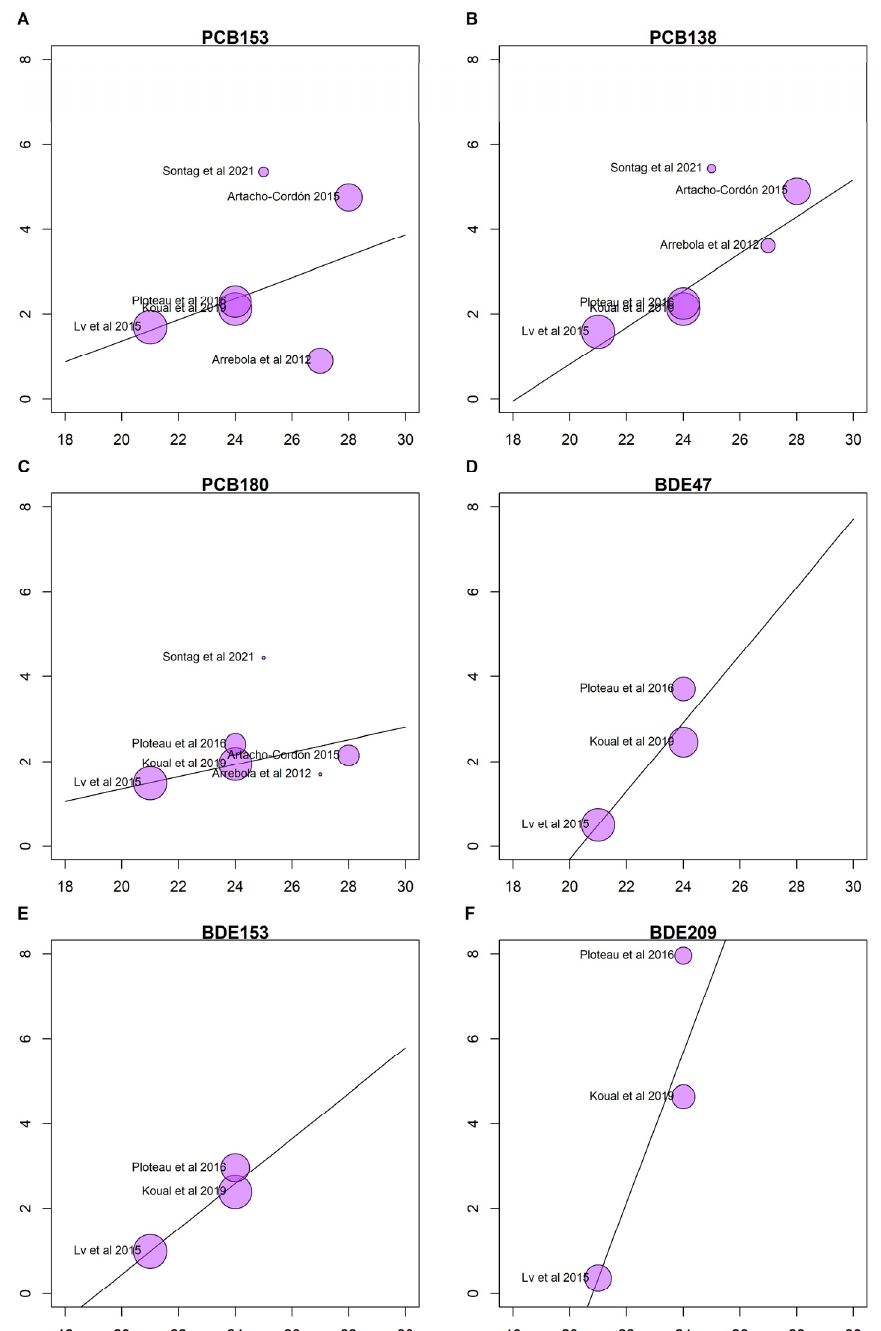
Figure 4. Bubble plots representing the associations between adipose tissue: serum ratios and body mass index (BMI) from the random effects meta-regression model for specific congeners including PCB 153 (Panel A ), PCB 138 (Panel B ), PCB 180 (Panel C ), BDE 47 (Panel D ), BDE 153 (Panel E ), and BDE 209 (Panel F ). The study [52] was excluded from this analysis because the BMI was not reported.